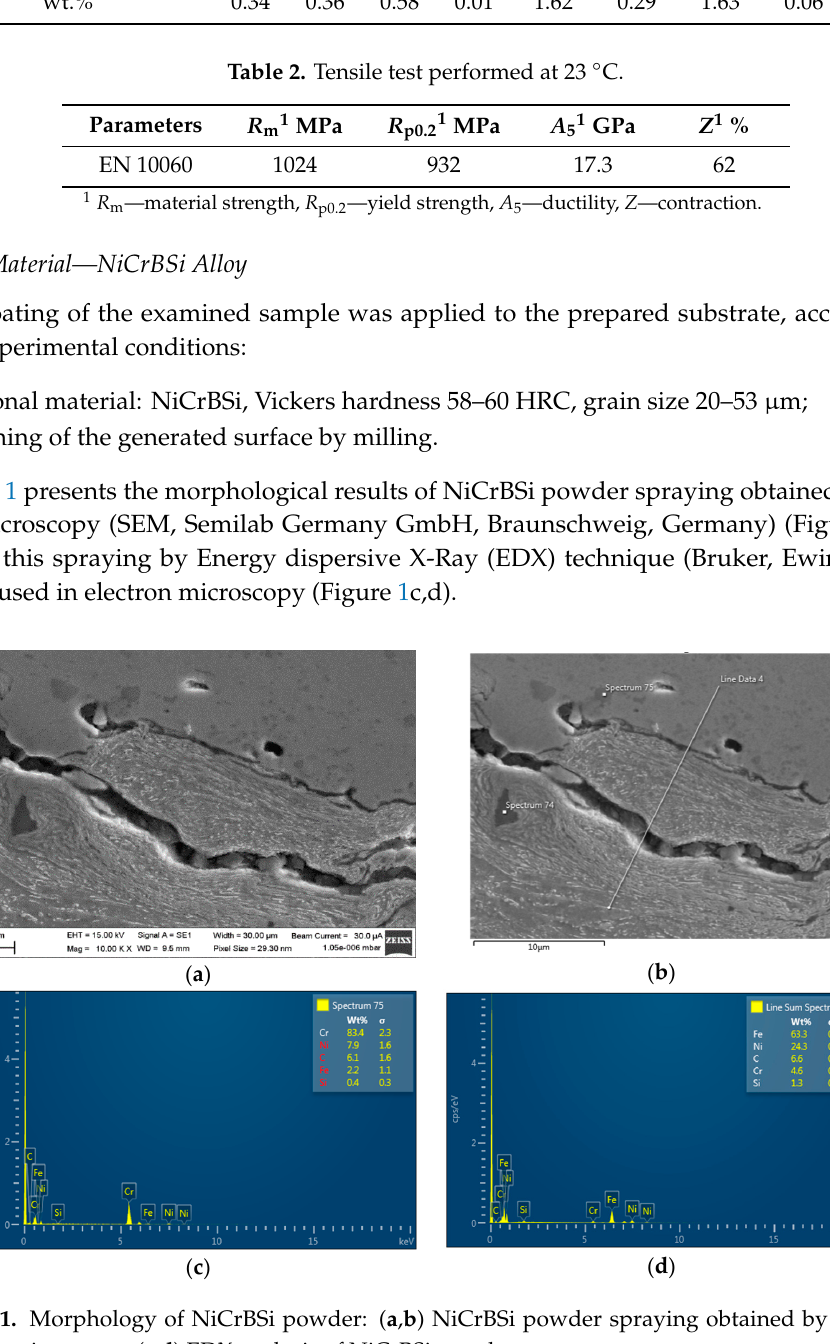
Table 1. Chemical composition.